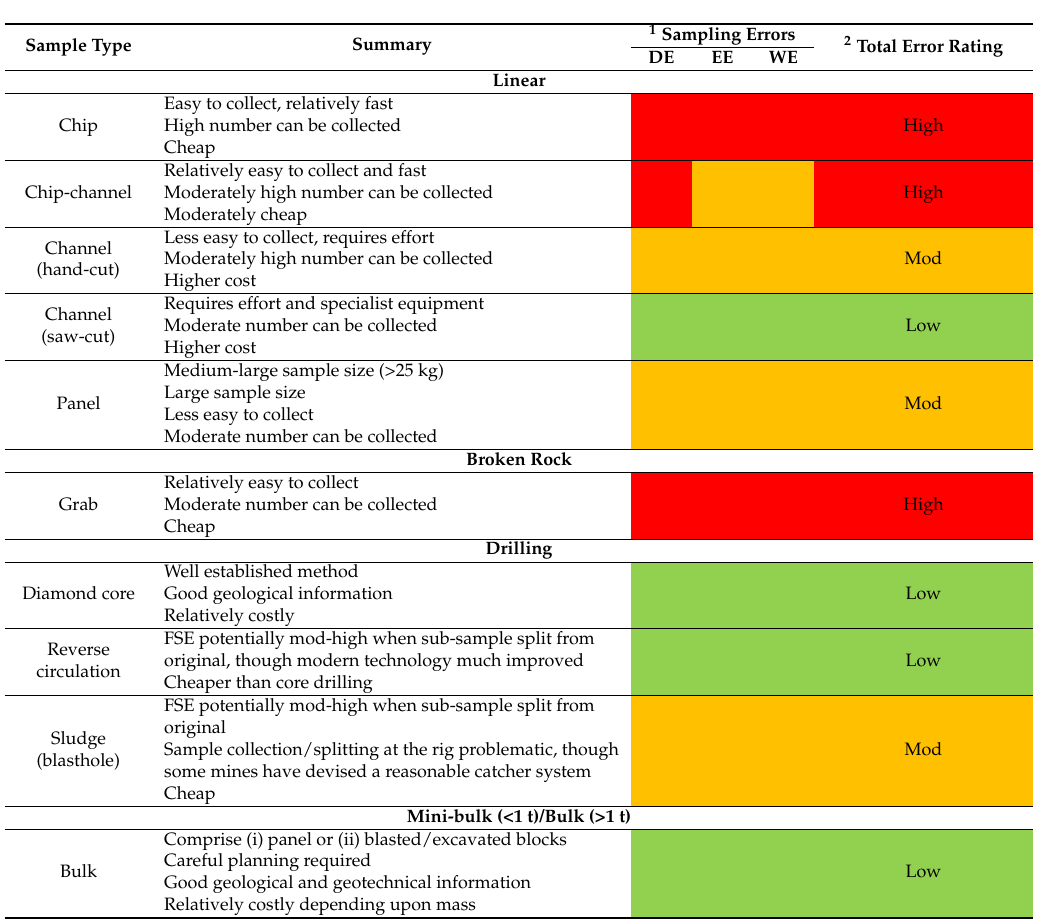
Table 28. Summary of sampling errors and risk rating for grade control sampling. For linear/broken rock sampling, it assumes a fully equipped two-person team to achieve best practice sample collection. Errors are best-case scenarios based on careful sample